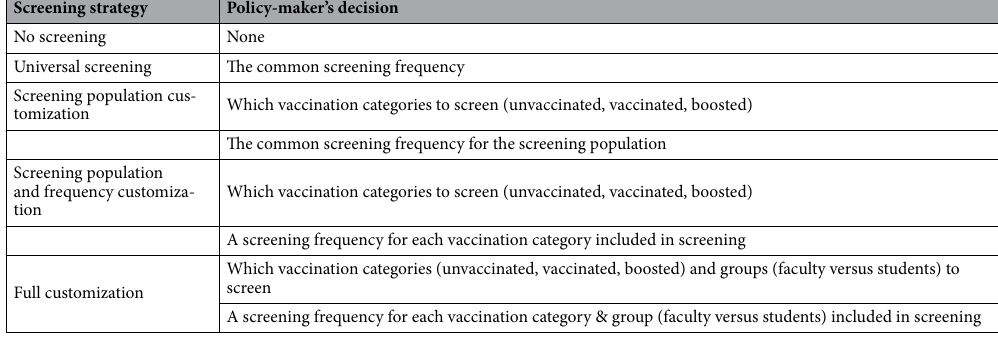
Table 1. Description of universal and customized screening